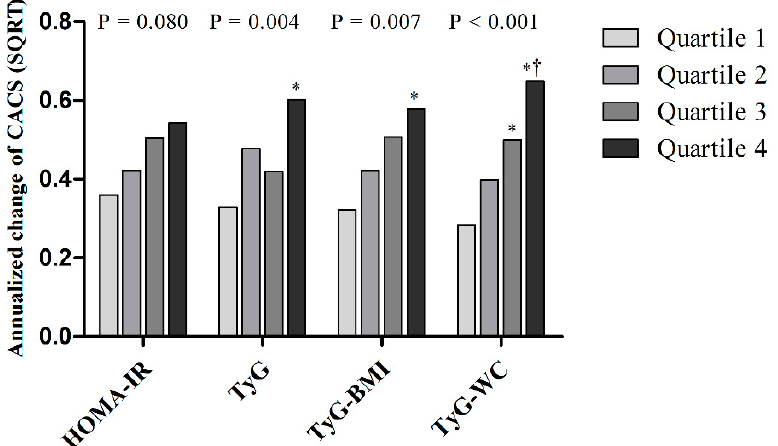
Figure 3. Annualized change of CAC according to quartiles of each parameter in the final cohort including non-progressors and progressors ( n = 1145). The p -values indicate overall p -value of the ANOVA and the symbols indicate results from the post hoc test of Scheffe’s method (* p < 0.05 vs. Quartile 1, † p < 0.05 vs. Quartile 2).